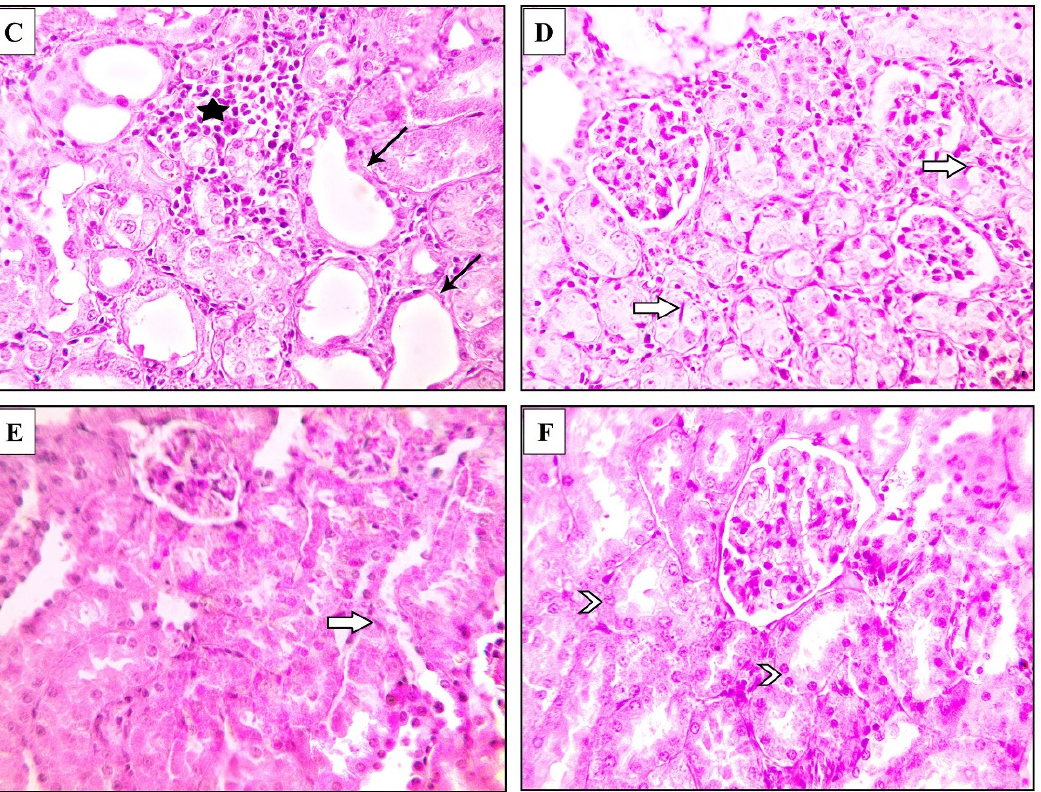
Figure 7. Microscopic pictures of H&E-stained renal sections showing ( A ) tubulointerstitial damage score in treated groups, Significant vs. control group refers to A, while significant vs. (cisplatin, -tocopherol, and baicalein) treatment groups refers to (B, C, D), respectively, ( B ) normal cortex and medulla in the control group, ( C ) leukocytic cell infiltration (star) and dilated tubules (black arrow) in cisplatin group, ( D ) mitotic figure (white arrow) in α -tocopherol group, ( E ) mitotic figure (white arrow) in baicalein group, and ( F ) prominent nuclei (arrowhead) in combined treatment group. High magnification ×: 400 bar 50